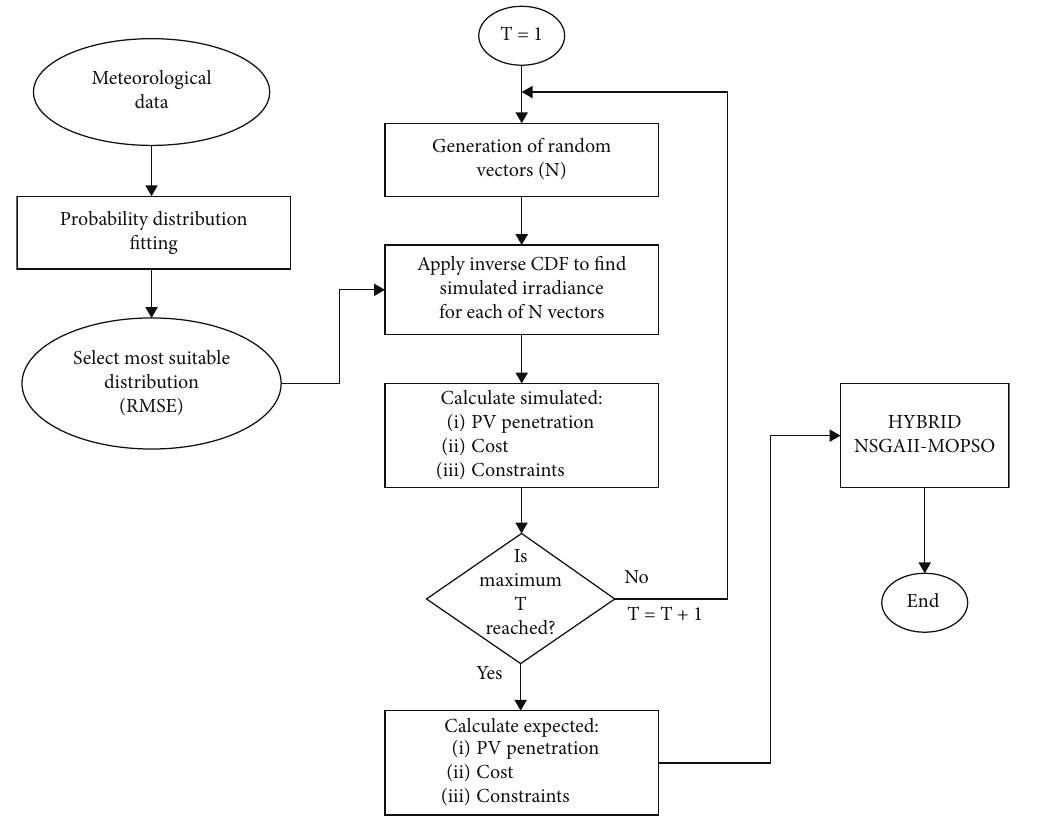
Figure 3: The Monte Carlo simulation strategy.